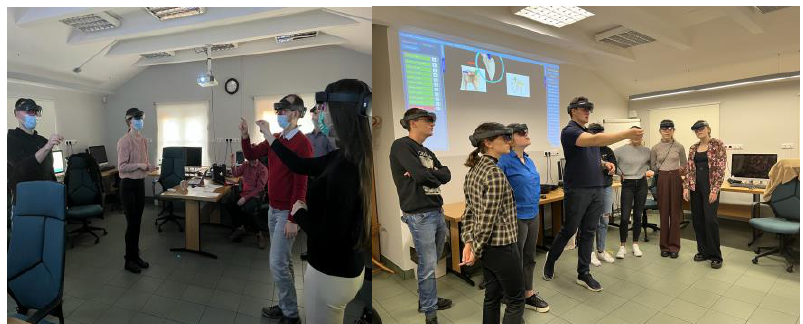
Figure 2. Mixed Reality Laboratory with students using HoloLens 2 at Jagiellonian University Medical College in Krakow.